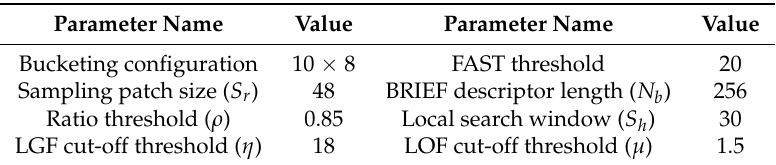
Table 2. Main parameters in our presented visual